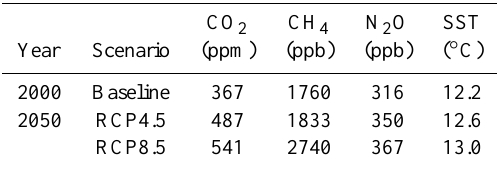
Table 1. Summary of main RCP4.5 and RCP8.5 anthropogenic greenhouse gas concentrations and global area-averaged sea-surface temperature (SST) for 2000 and